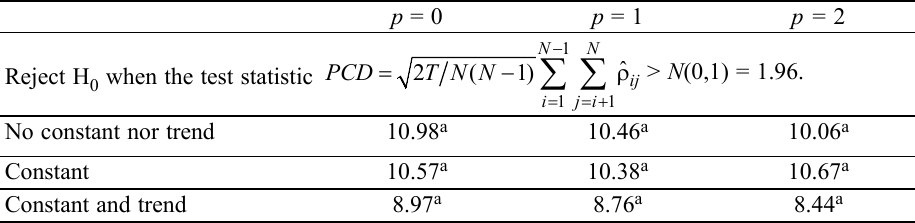
Table 3. Pesaran cross dependency (PCD) tests for 19